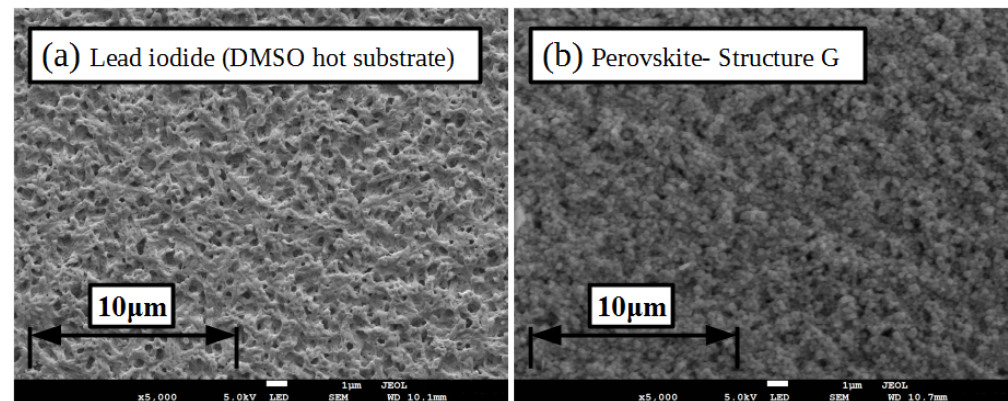
Figure 9. SEM images of ( a ) lead iodide film from coating on 100 ◦ C substrates and ( b ) the perovskite film formed from coating MAI in ethanol on the resulting film. Inset scale-bar lengths are given in inset labels.